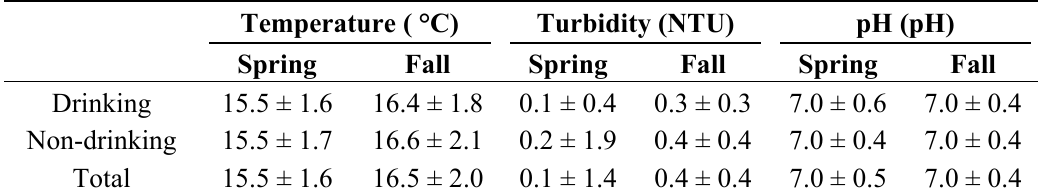
Table 2. Average of temperature, turbidity, and